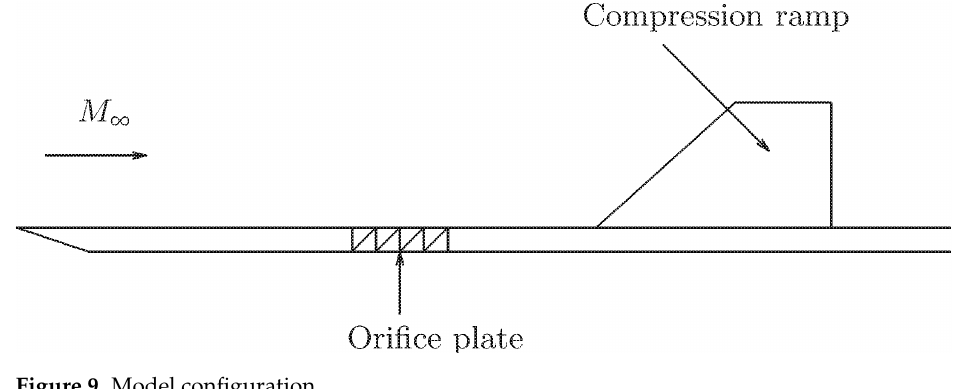
Figure 9. Model configuration.